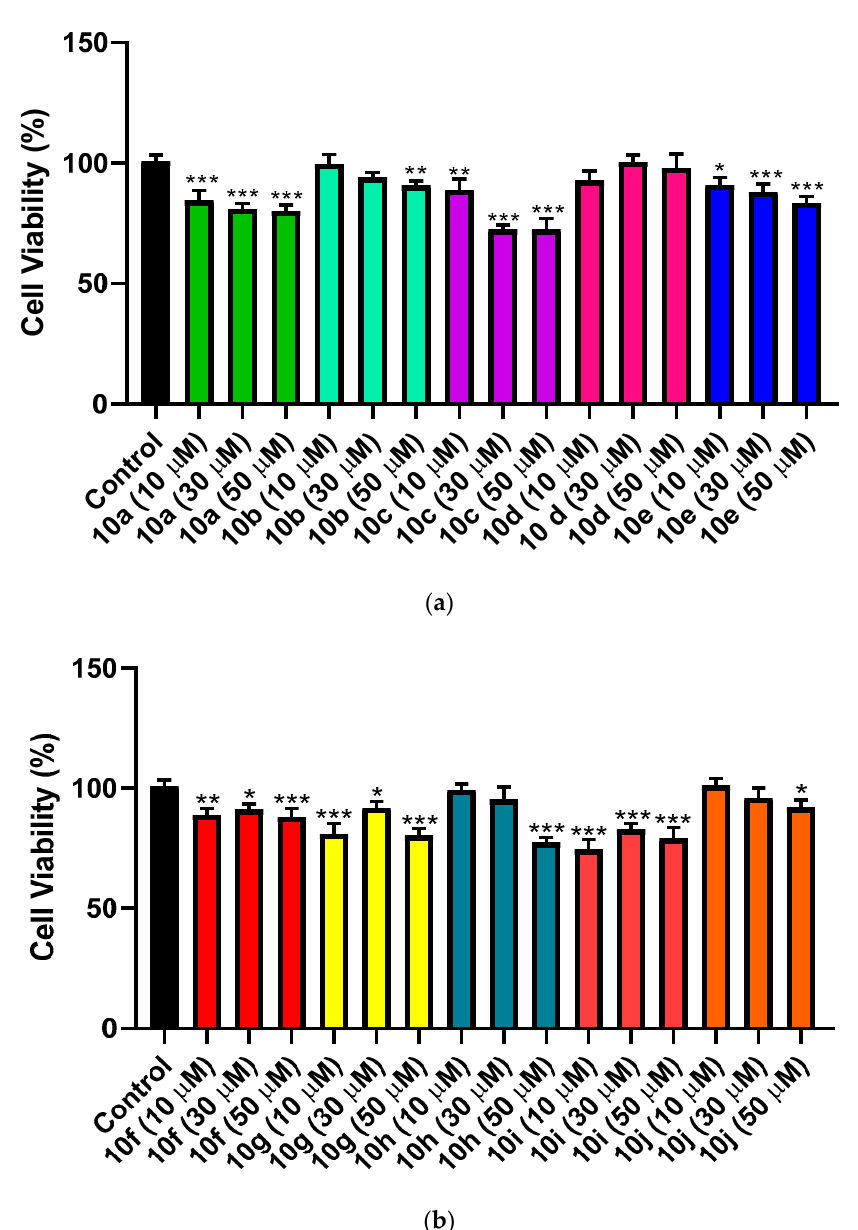
Figure 2. ( a ) Effect of hybrids 10a–e on viability of normal hepatic LO2 cells. ( n = 5). ( b ) Effect of hybrids 10f–j on viability of normal hepatic LO2 cells ( n = 5). *** Significant from control group at p < 0.001, ** Significant from control group at p < 0.01, * Significant from control group at p <